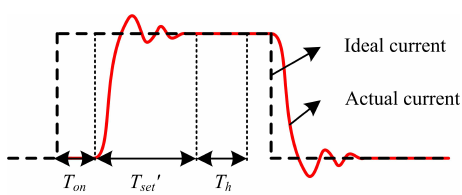
Figure 6. The actual current and ideal current in the proposed method.